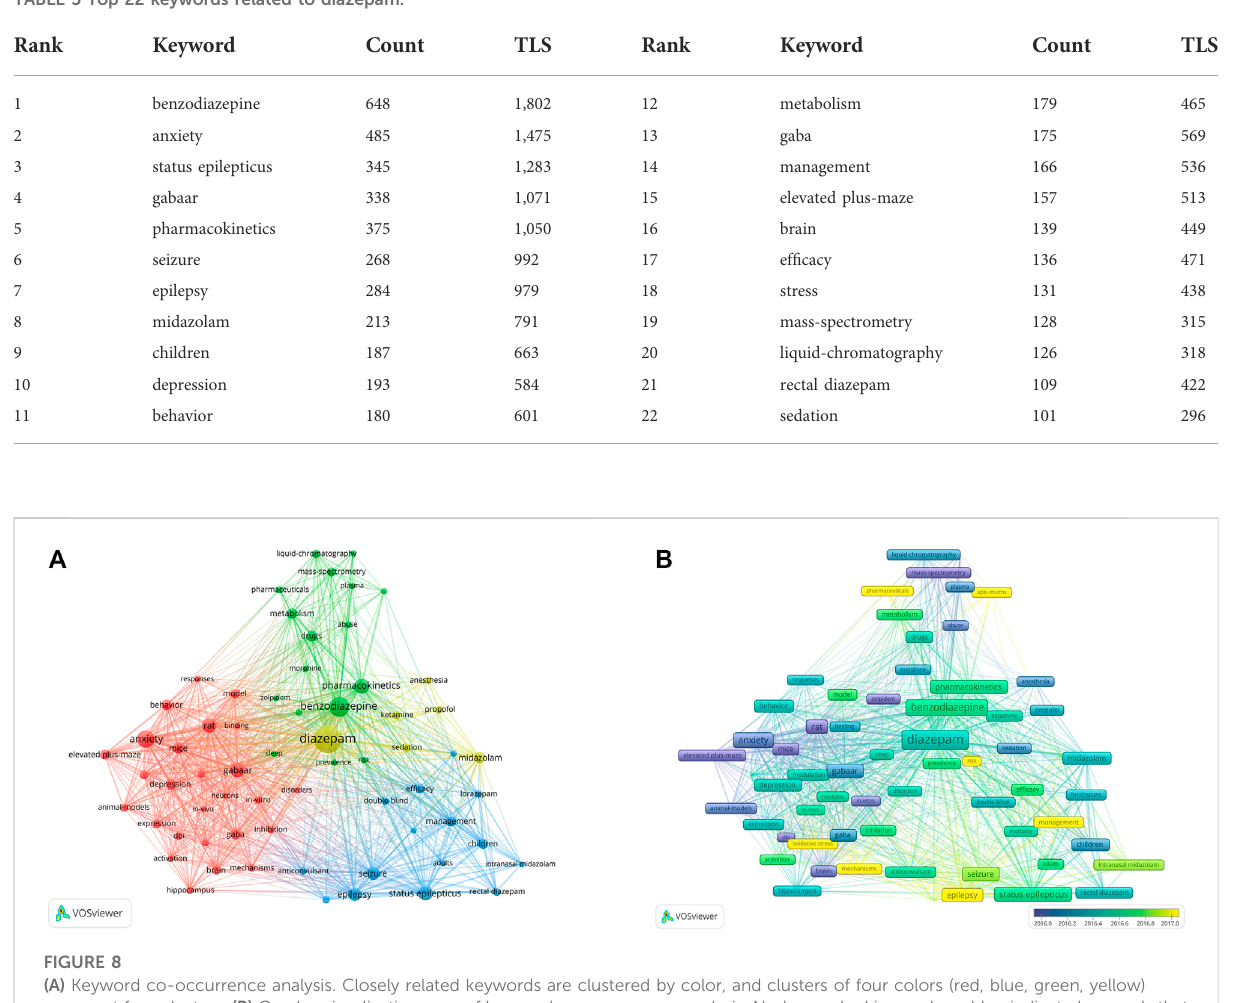
TABLE 5 Top 22 keywords related to diazepam.